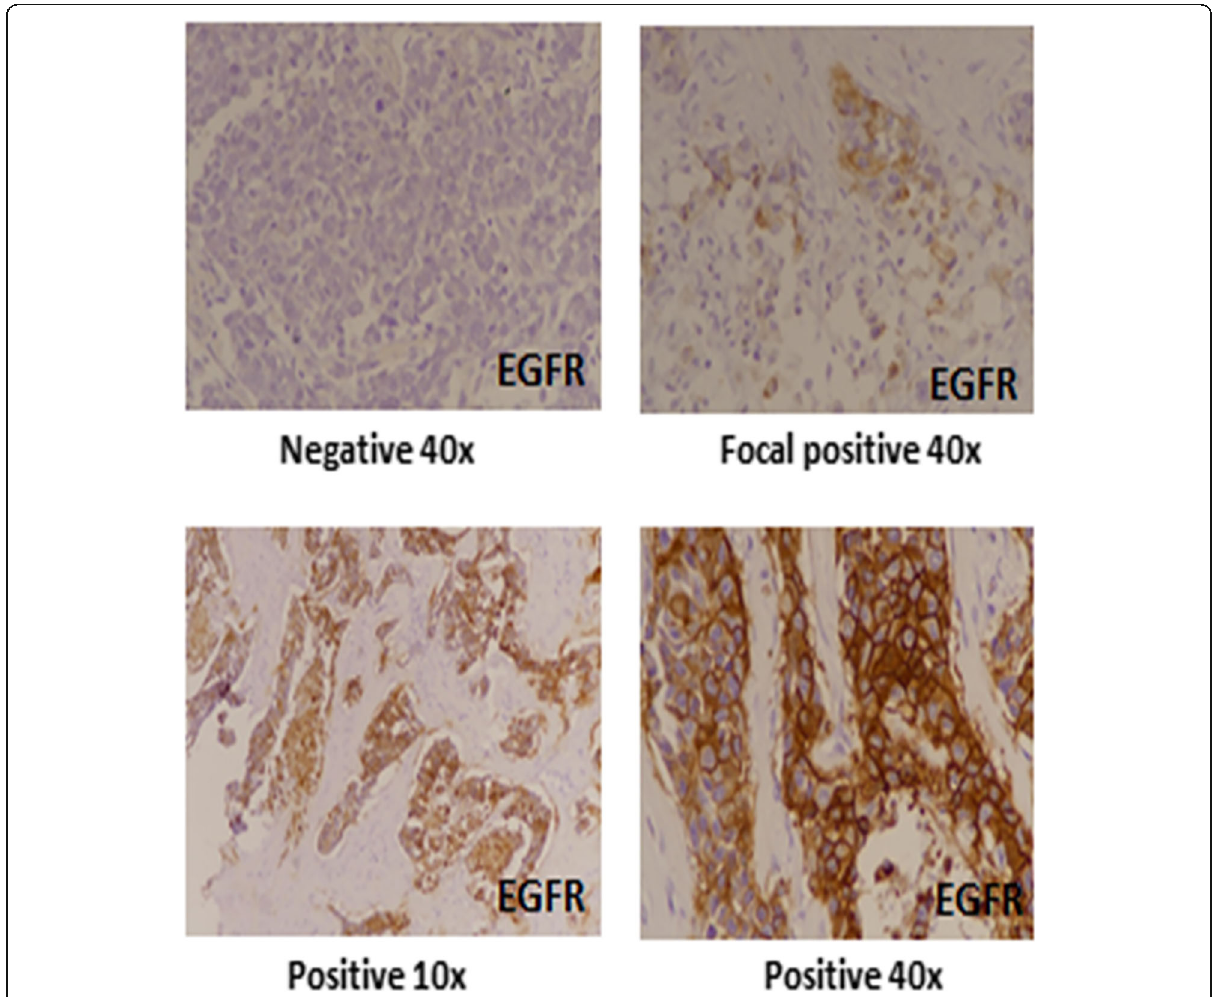
Fig. 1 EGFR expression in triple negative breast cancer. Membranous and cytoplasmic staining was considered